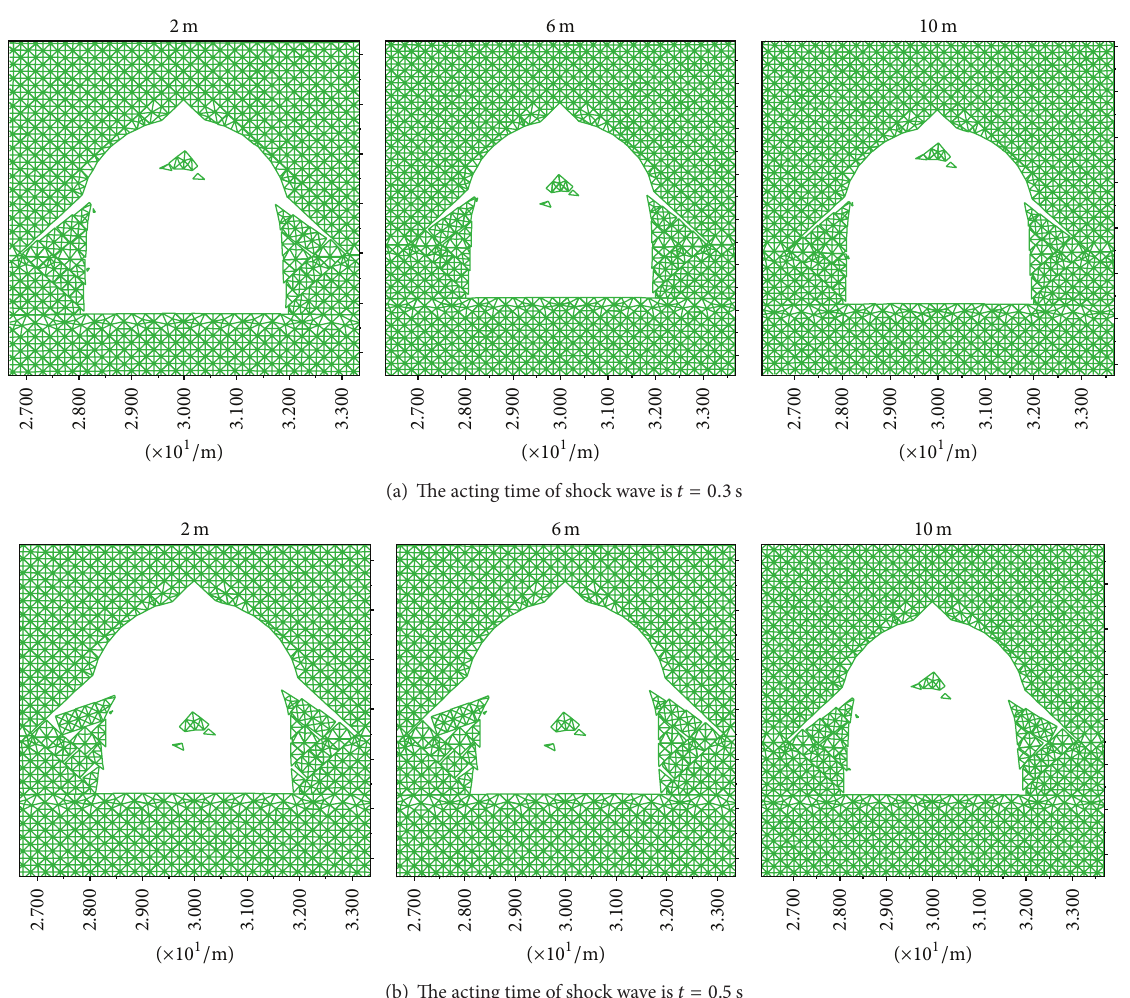
Figure 7: Rockburst failure of roadway at 𝑡 = 0.3 s and 0.5 s of shock wave acting time. Note: 2 m, 6m, and 10m represent the immediate roof thickness, respectively.